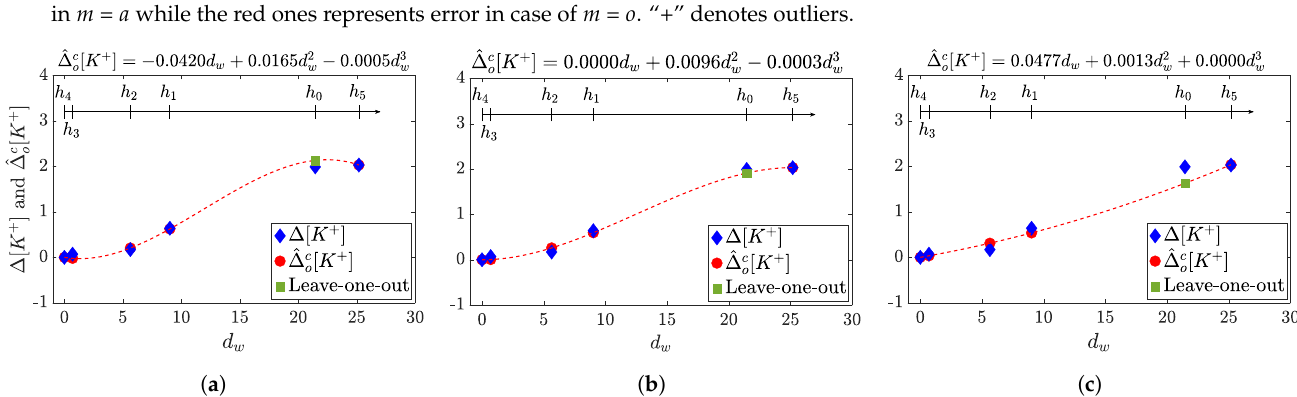
Figure 5. Examples of cubic models (red dotted lines) computed for a given patient by imposing different parameter restrictions for leave-on-out cross-validation method, the corresponding equations are reported above each panel. The re- sulting model without restrictions on { α c , β c , γ c } is in panel ( a ), while those from imposing α c ≥ 0, or full constrained model are presented in ( b , c ) respectively. In each panel: The blue diamonds represent measured ∆ [ K + ] values at the hours { h } ; while red dots are the estimated ˆ ∆ c [ K + ] corresponding to the computed d w used in the training 0 , h 1 , h 2 , h 3 , h 4 , h 5 d w , o [ K + ] corresponding to the d w at h set and computed at { h 1 , h 2 , h 3 , h 4 , h 5 } ; the green square is the estimated ˆ ∆ c 0 , the hour d w , o excluded from the training set in this example, and then the one with higher risk for error in the estimation. See that only full set of parameters forced to be positive result in a monotonic, physiologically plausible,